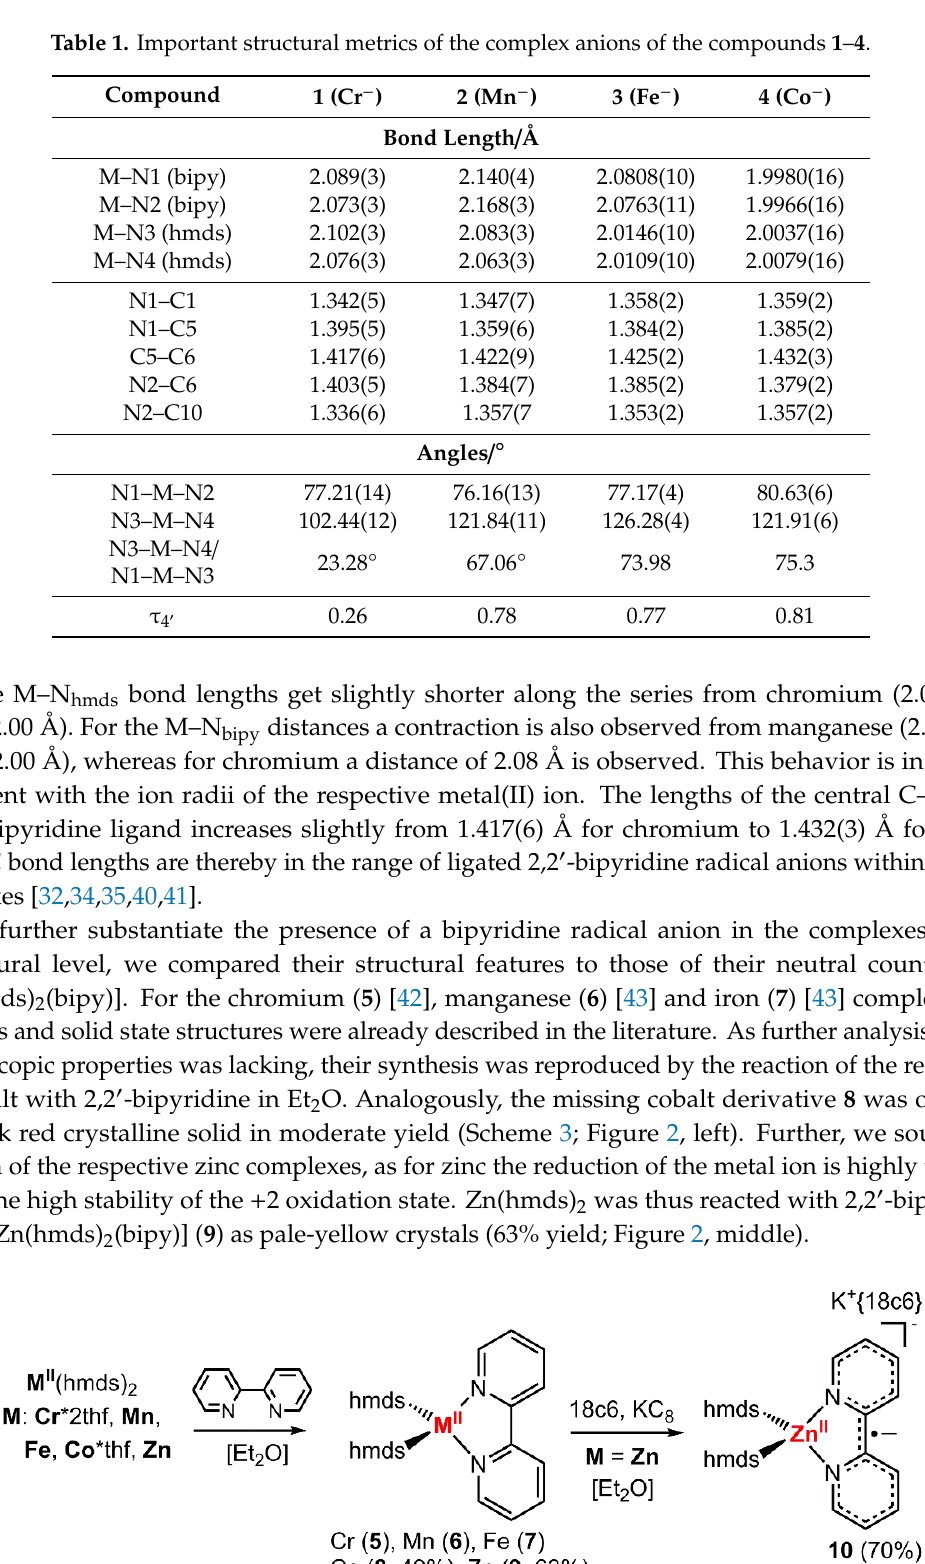
Table 1. Important structural metrics of the complex anions of the compounds 1 – 4 .